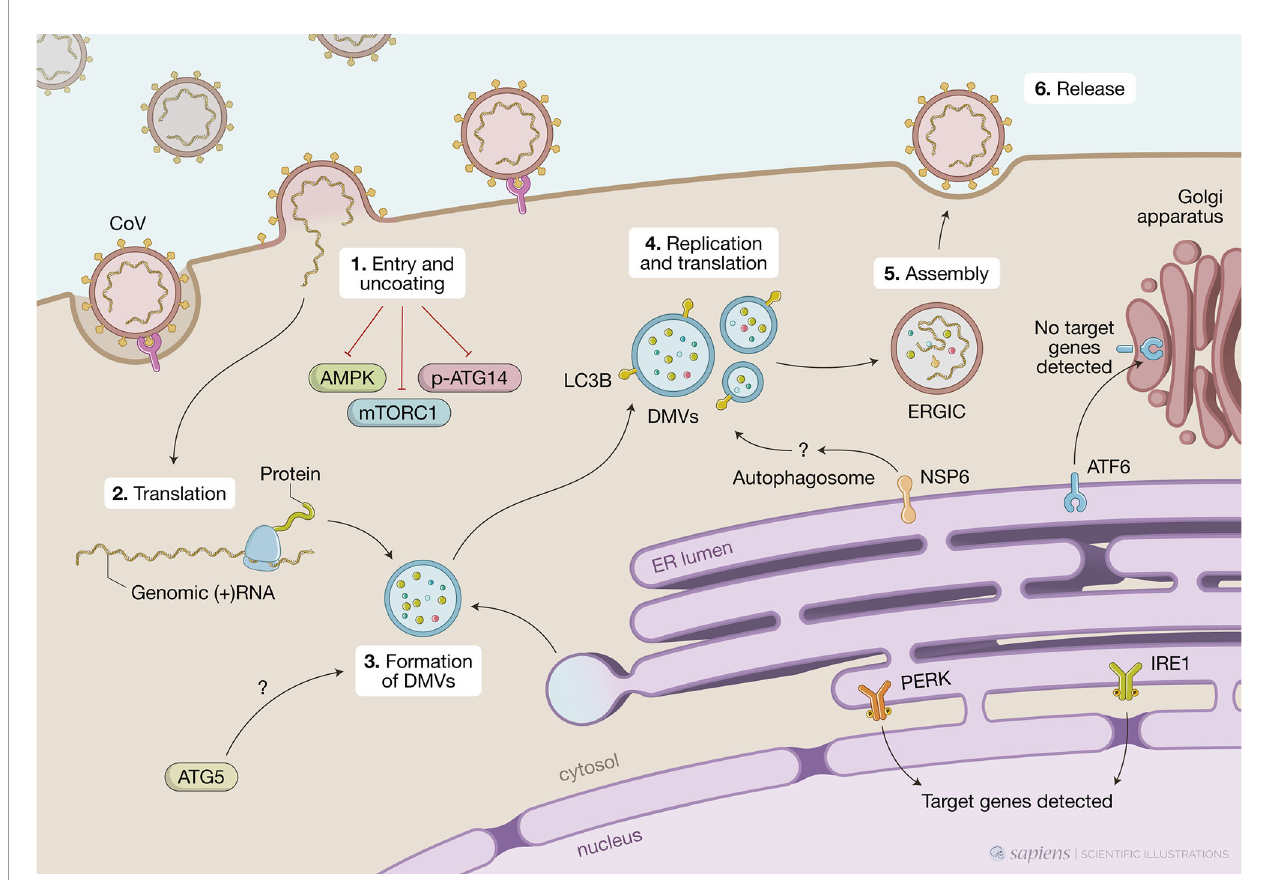
FIGURE 2 | Unfolded protein response (UPR), autophagy and coronavirus (CoV) infections. This fi gure represents data obtained by using different cell models infected by CoV viruses mouse hepatites virus (MHV), infectious bronchitis virus (IBV), SARS-CoV or SARS-CoV-2. CoV infection begins when the viral S protein attaches to its complementary host receptor, allowing the virus to enter the host cells by endocytosis or direct fusion of the viral envelop with the host membrane. The process of SARS-CoV2 virus entry and uncoating (1) downregulates AMPK and reduces phosphorylation of ATG14, disrupting the autophagy fl ux, while simultaneously inhibiting mTORC1, which promotes autophagy. Once inside the cell, the viral positive-sense RNA is translated (2) and the virus induces massive rearrangement of the intracellular membrane network to generate double membrane vesicles (DMVs) (3). CoV-induced DMVs may originate from late endosomes, autophagosomes or vesicles from the early secretory pathway. MHV-induced autophagy was impaired in cells lacking ATG5, which displayed a deranged morphology of the membranes and decreased viral yield. Nonlipidated LC3 extensively colocalizes with DMV protein markers and downregulation of LC3 protects cells from CoV infection as result of defects in DMVs biogenesis. CoV replication occurs within DMVs and transmembrane structural proteins (S, M and E) are synthesized in the ER (4). Non-structural protein NSP6 from IBV, MHV and SARS-CoV are localized in the ER and participate in autophagosome formation via omegasomes, which could be used for DMV formation. Finally, new viral particles are transported to the ER-Golgi intermediate compartment (ERGIC) for assembly (5) and exported through secretory pathway in smooth-wall vesicles, which ultimately fuse with the plasma membrane to release the mature virus (6). A high demand for membranes for DMV formation and virion exocytosis contributes to ER stress. MHV activates PERK/eIF2 a and IRE1 and target genes from these two branches are detected upon infection. Cleavage of ATF6 can also be observed but no target genes are detected